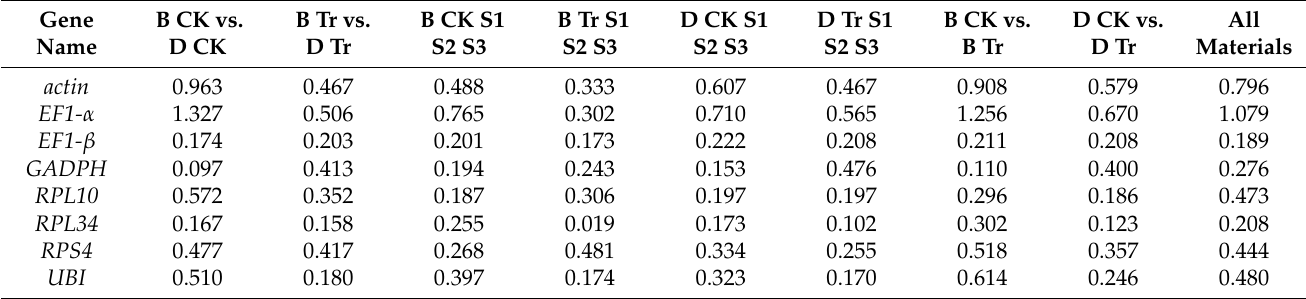
Table 4. Rank of candidate reference genes were calculated by NormFinder in each